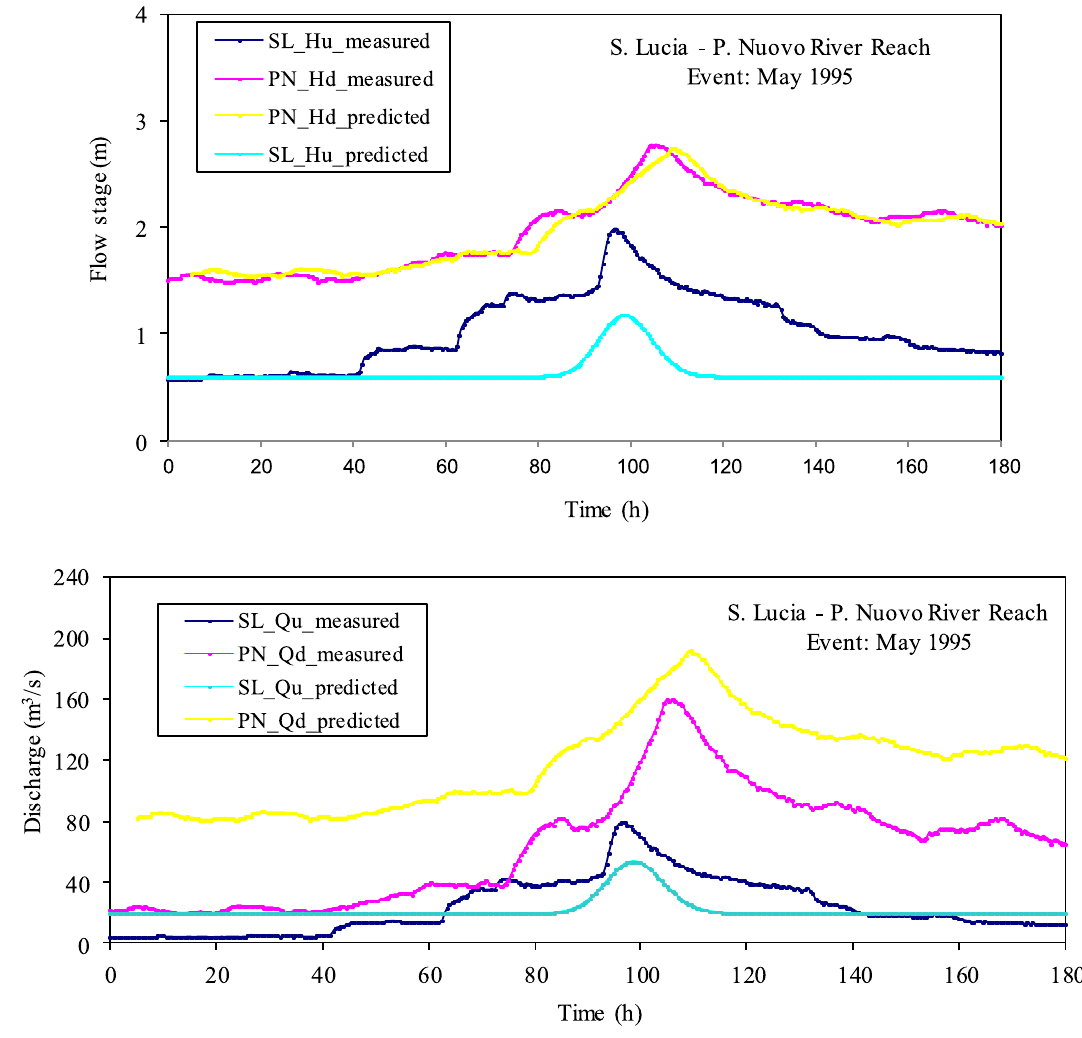
Fig. 4 Flow stage (above) and flow discharge (below) hydrograph simulations for event May 1995 in S. Lucia and P. Nuovo river